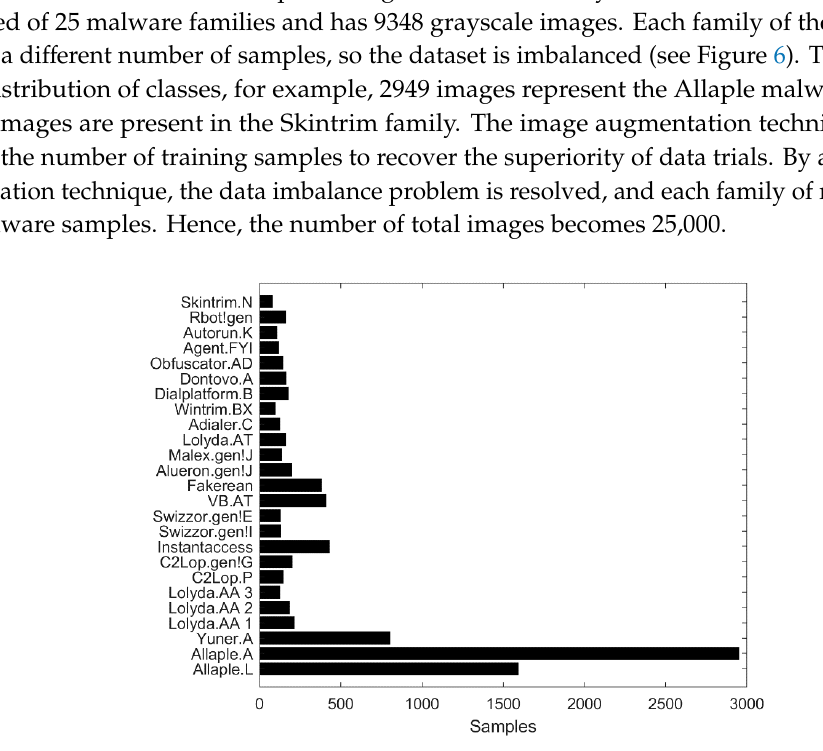
Figure 6. Distribution of samples in the Malimg dataset [51].